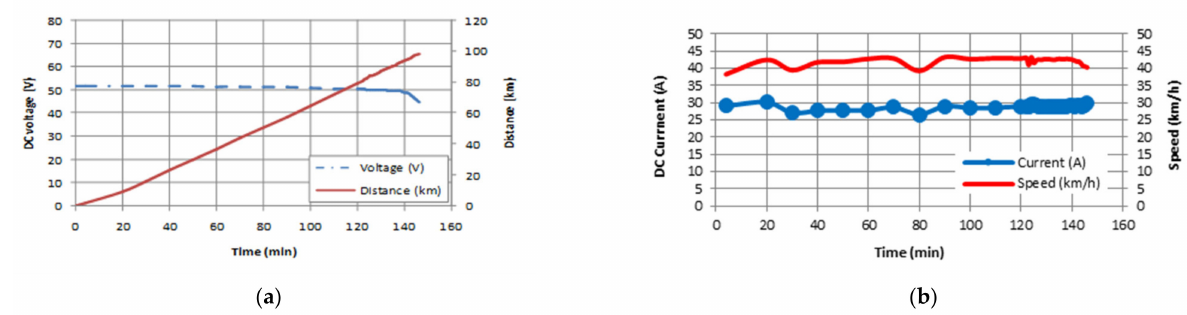
Figure 20. ( a ) Measured DC voltage and distance; ( b ) measured DC current and vehicle speed.